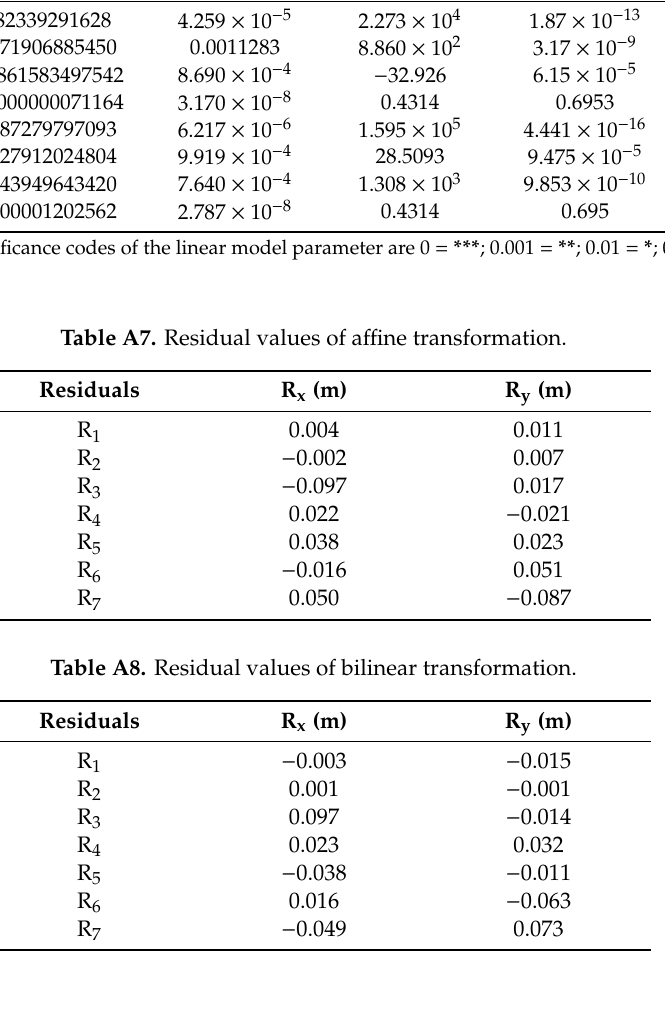
σ ), probability and